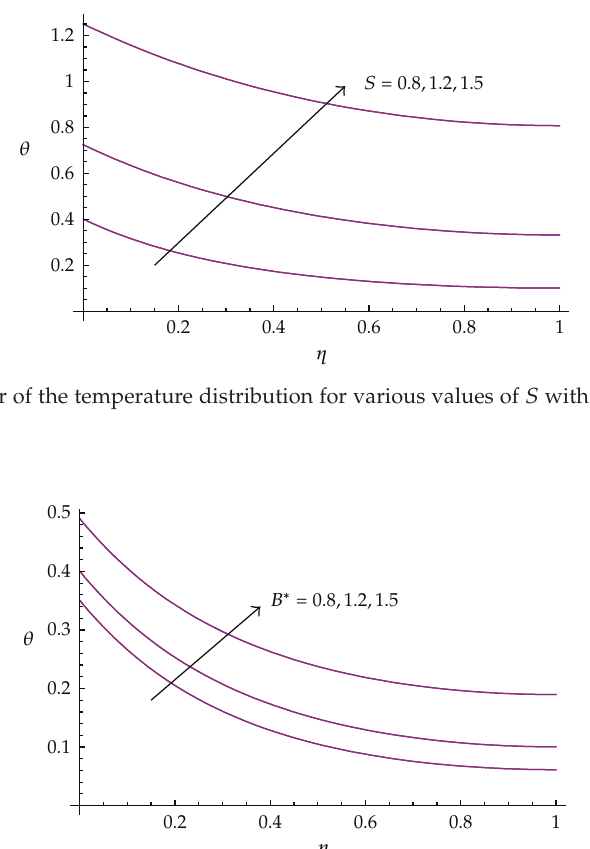
Figure 3: The behavior of the temperature distribution for various values of B ∗ with S (cid:7) 0 . 8, R (cid:7) 0 . 5, and Pr (cid:7)